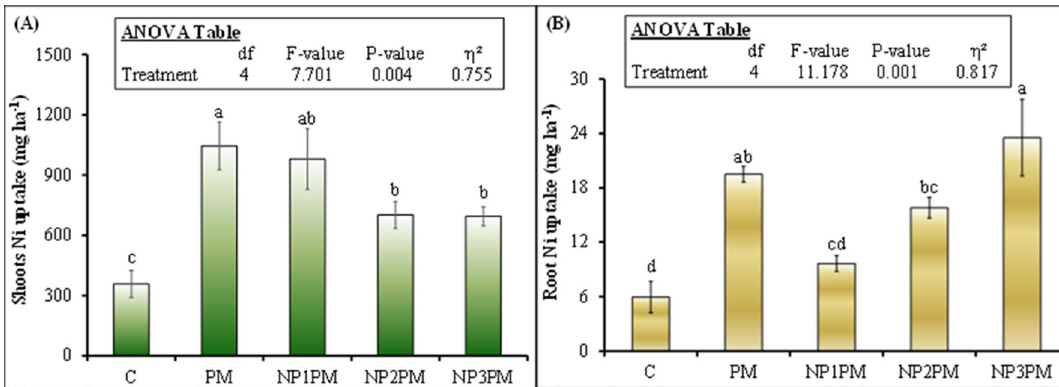
Figure 5. Mean (n = 3) ryegrass ( A ) shoot (total of 3 cuts) and ( B ) root Ni uptake after sole and combined application of poultry manure (PM) with nickel nanoparticle (NP). Treatments abbreviation can be found in the legend of Fig. 1. Error bars showed standard errors (± 1 SE) of the mean. Different small letters illustrated significant differences among treatments at a 5% probability level after the Tukey-HSD test. Inset table represented the outcomes of analysis of variance